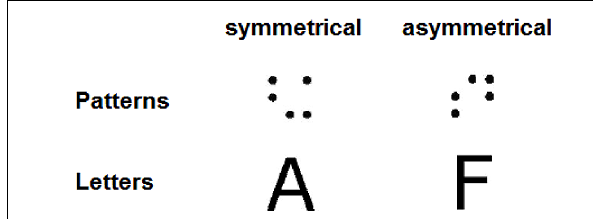
FIGURE 2 | Examples of symmetrical and asymmetrical dot-pattern (first used by Garner and Clement, 1963) and letter stimuli used in Lachmann and van Leeuwen (2007).